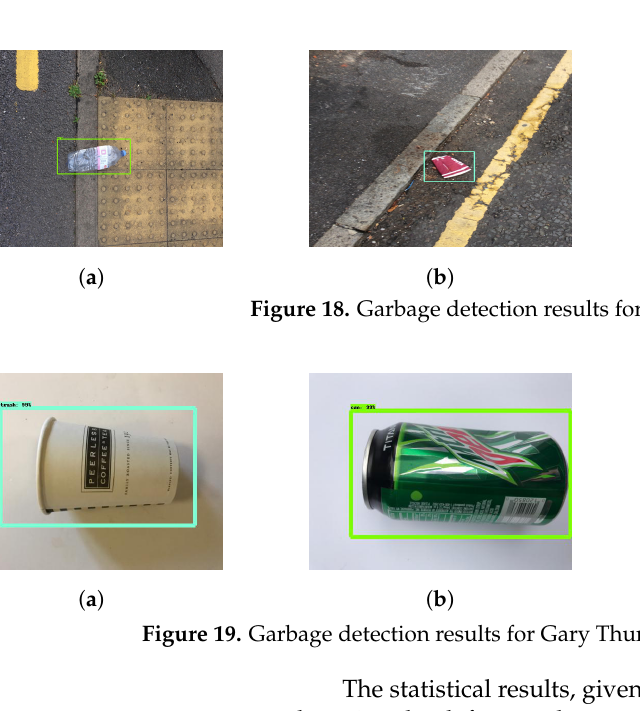
Figure 17. Defect detection results for Hiroya Maeda road damage data-set in ( a – d ).